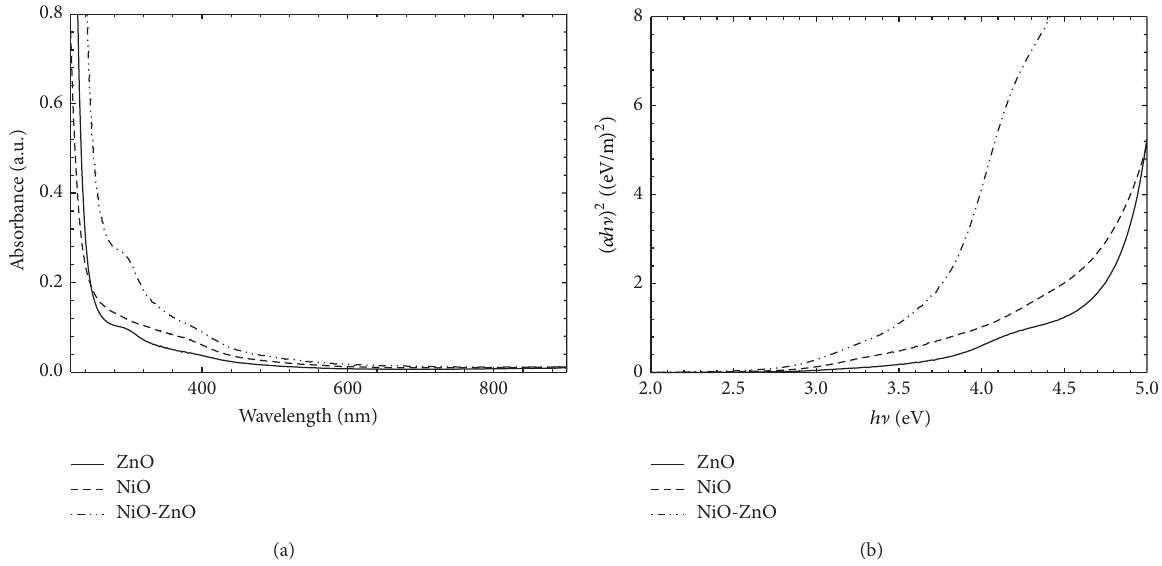
Figure 4: UV-Vis spectrum of (a) fresh solution absorption and (b) curve of (𝛼ℎ𝜐) 2 against ℎ𝜐 for NiO NPs, ZnO NWs, and NiO-ZnO NCs.